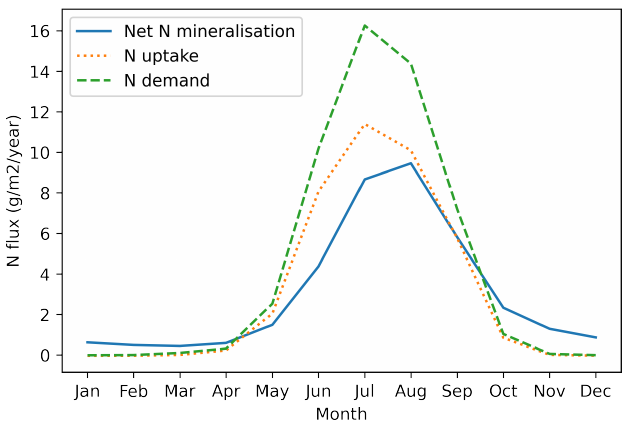
Figure 2. Ensemble mean seasonal cycle of net N mineralisation, N demand and N uptake for the period 2000–2009 and spatially averaged over the simulated permafrost region shown in Figure 1a.